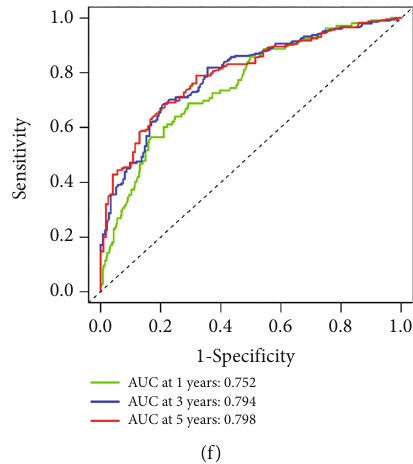
Figure 5: Independent prognostic and survival time predictive value of the risk signature. (a, b) Univariate Cox analysis and multivariate Cox analysis were utilized to evaluate the independent prognostic value of the signature. (c) Receiver operating characteristic curve was plotted to prove the superiority of the risk score in predicting patient ’ s survival than clinical characteristics. (d) A nomogram was constructed to predict patients ’ survival time by using indicators with independent prognostic function. (e, f) A calibration curve and a ROC curve were plotted to test the accuracy of the nomogram at 1, 3, and 5 years,